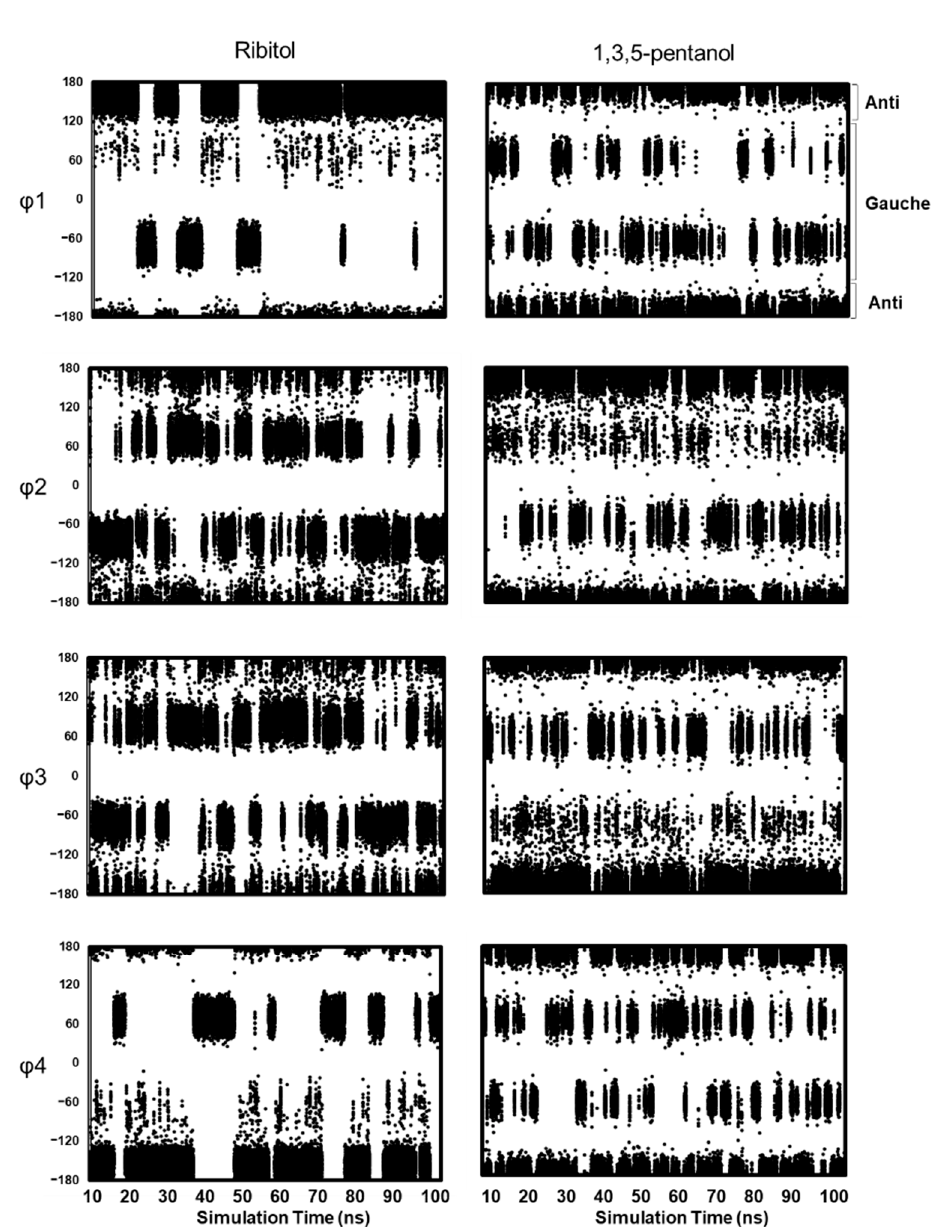
Figure 6. Dihedral angle distribution of ribitol (left, Run#1) and 1,3,5-pentanol (right) in MD simulations. The results of each dihedral angle are shown after 10 ns. The dihedral angles are defined as ϕ 1 (O1–C1–C2–C3), ϕ 2 (C1–C2–C3–C4), ϕ 3 (C2–C3–C4–C5), and ϕ 4 (C3–C4–C5–O5). ϕ 1 and ϕ 4 of ribitol are mostly distributed in anti (180 ◦ ) and gauche ( − 60 ◦ for ϕ 1 and +60 ◦ for ϕ 4) (Supplementary Table S2). This is consistent with the NMR result, in which the populations of dihedral angle ϕ 1 are estimated as 180 ◦ : − 60 ◦ :60 ◦ = 64:36:0. For ϕ 2 and ϕ 3 of ribitol, gauche conformations ( − 60 ◦ and +60 ◦ ) are dominant, but the anti-conformation is also populated. This is consistent with the NMR result (180 ◦ : − 60 ◦ :+60 ◦ = 2:46:52). To validate the MD results quantitatively, 3 J (H,H) and 3 J (C,H) are calculated from the population of anti and gauche conformations, and the calculated J values are compared with experimental values (Table 3). The calculated J values are mostly consistent with the experimental values, suggesting that MD simulation quantitatively reflects the energy level of each conformer based on the Boltzmann distribution.